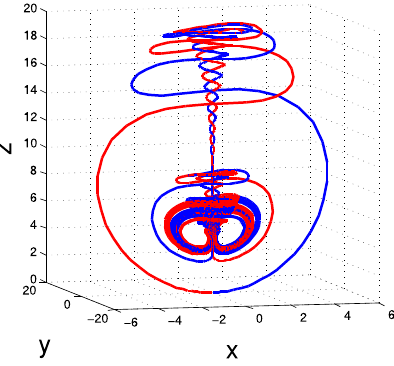
Figure 5. The phase portrait of system (1.3) for ( a,b,c ) = (3 , 4 , 0 . 1), time of integration: [0 , 750], and initial conditions: ( x 0 ,y 0 ,z 0 ) = ( ± 3 . 82 × 1 e − 5 , ± 6 . 18 × 1 e − 5 , 0). The figure suggests the existence of chaotic attractors which are bifurcated from the singularly degenerate heteroclinic cycles of system